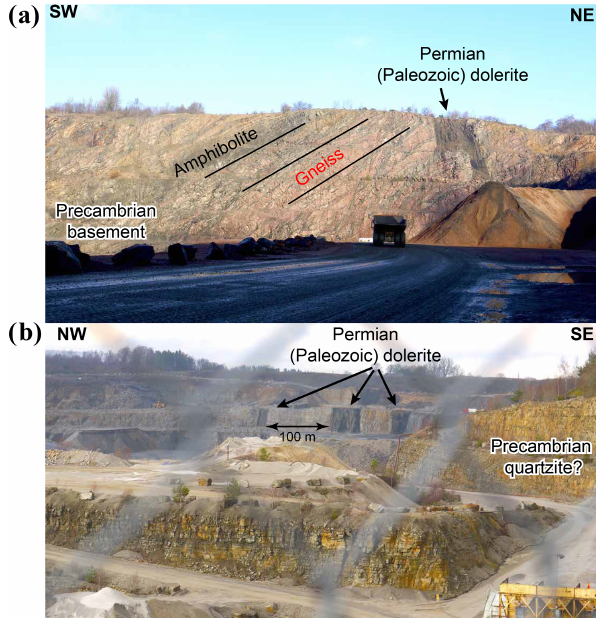
Figure 2. Example photos showing typical doleritic dykes within the Scania area (a) from the Dalby rock quarry (about 500m north of the study area) and (b) a quartzite quarry (about 2km northwest of the study area). The dykes appear, 10–50m thick, in a regular or- der typically 50–100m far apart and crosscut stratigraphy and am- phibolites. They tend to be subvertical in most places that they have been observed on land. In the Dalby quarry, these dykes make up to 5% of the rocks excavated. Gneiss and amphibolite are abundant and typically equality constitutes the remaining bulk volume of the excavated rocks. Photos are from Alireza Malehmir (July